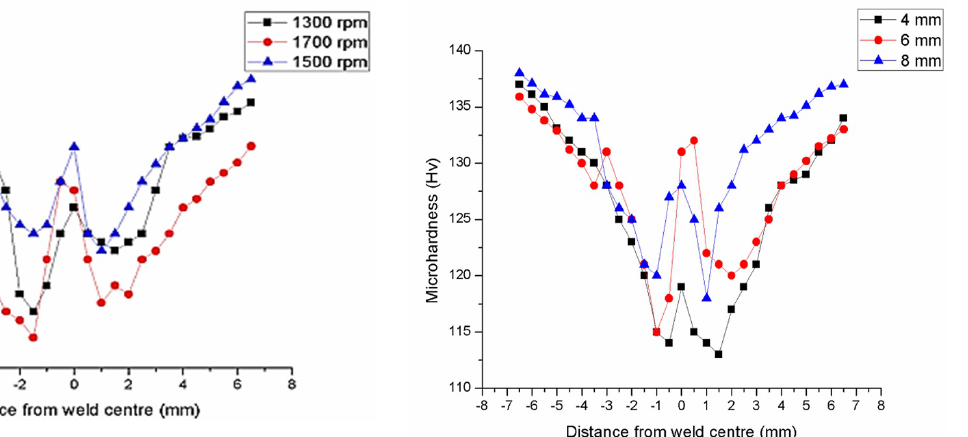
Figure 12: Effect of rotational speed on microhardness